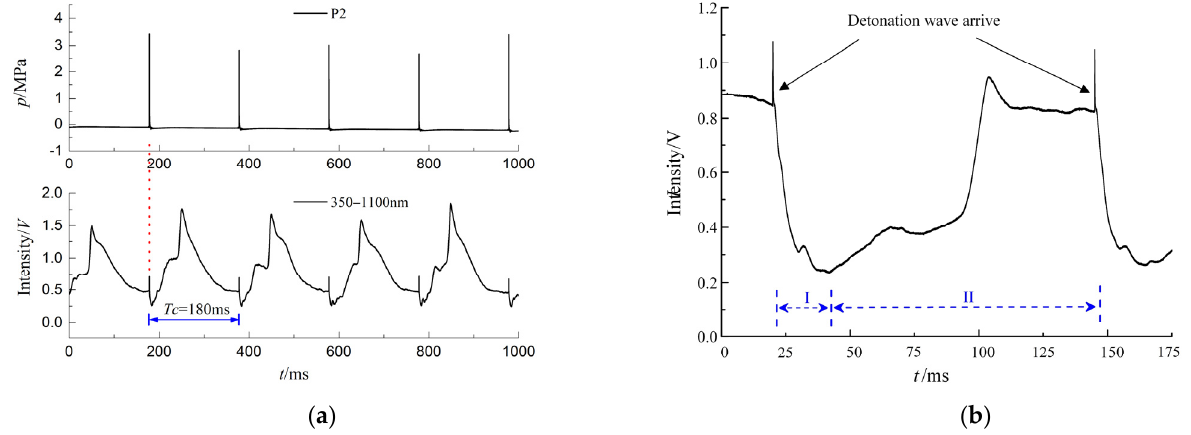
Figure 6. ( a ) Radiation signal under multi-cycle detonation, ( b ) Radiation signal with fill fraction 70%. (I. detonation wave exits from the tube; II: detonation products exhaust from